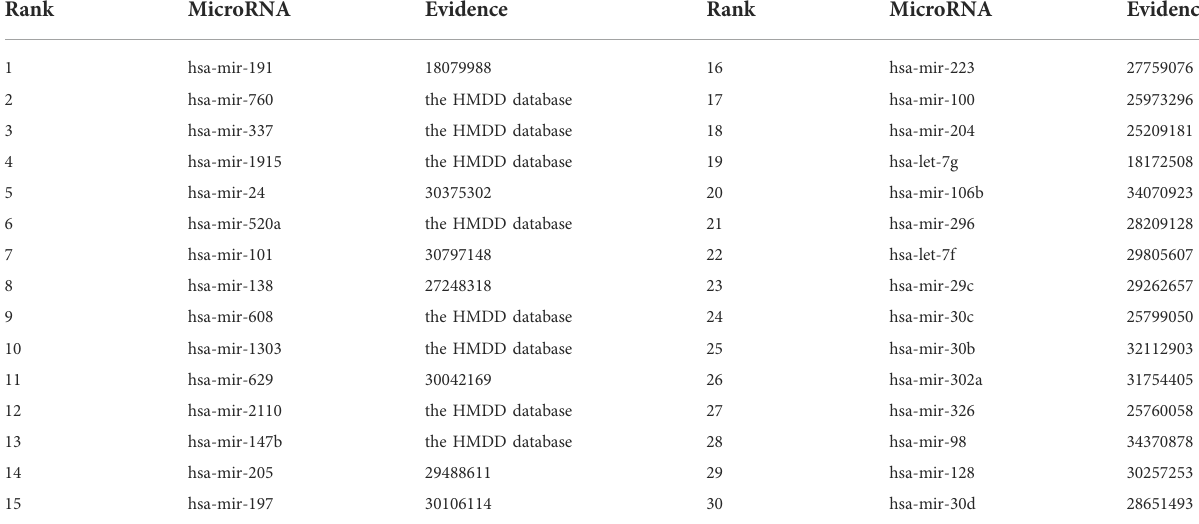
TABLE 3 The inferred top 30 microRNAs associated with colorectal cancer except for 129 known microRNAs.